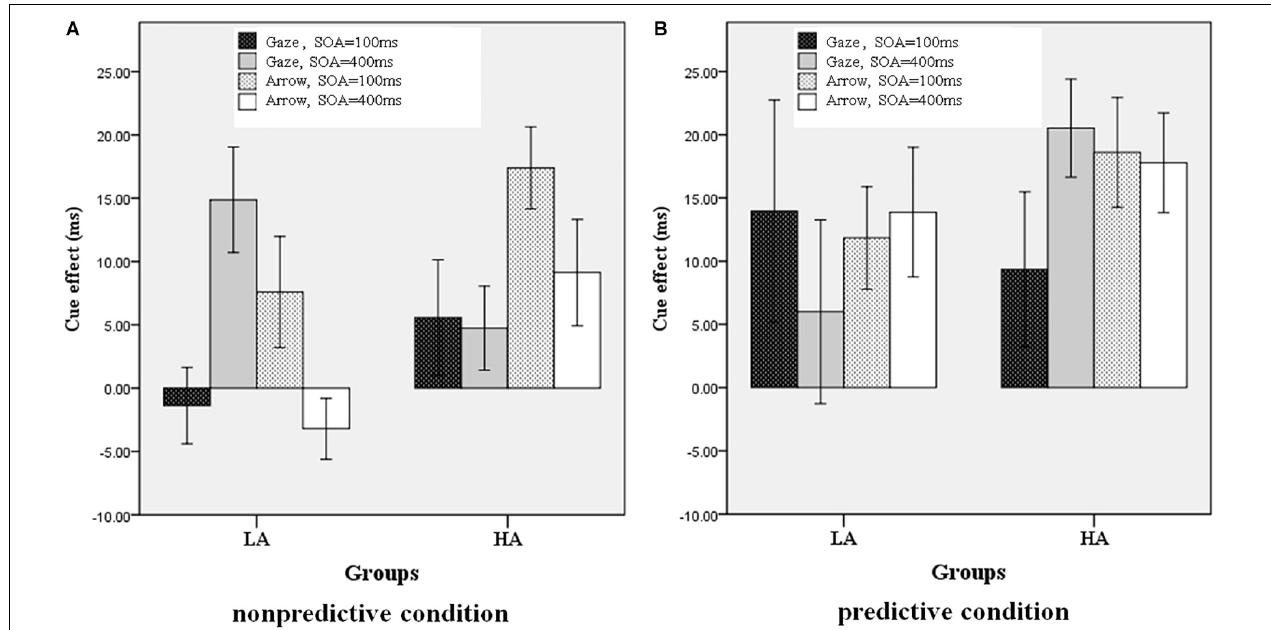
FIGURE 2 | Cue effect in all conditions for the LA and HA groups. (A) Non-predictive condition, (B) predictive condition.